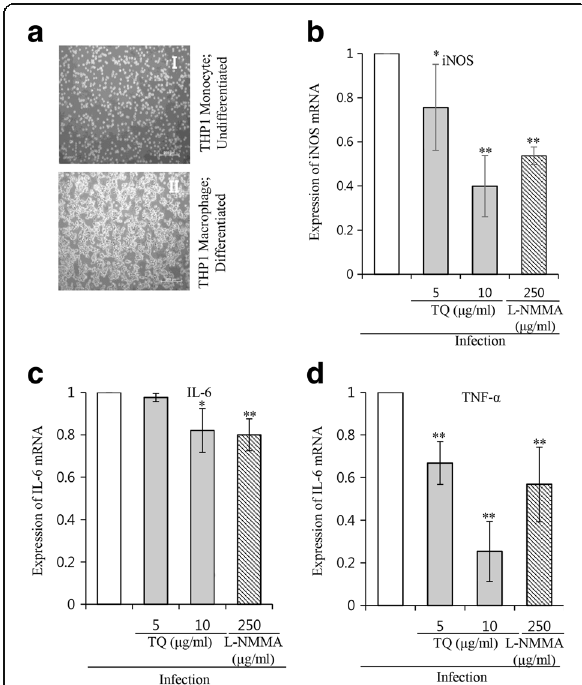
Fig. 4 The effect of TQ on MTB-induced NO expression in human monocyte THP-1 cells. THP-1 monocytes were differentiated into macrophages by 200 nM PMA treatment. The cells were imaged at ×10 magnification with an inverted microscope (ZEISS; Axiovert